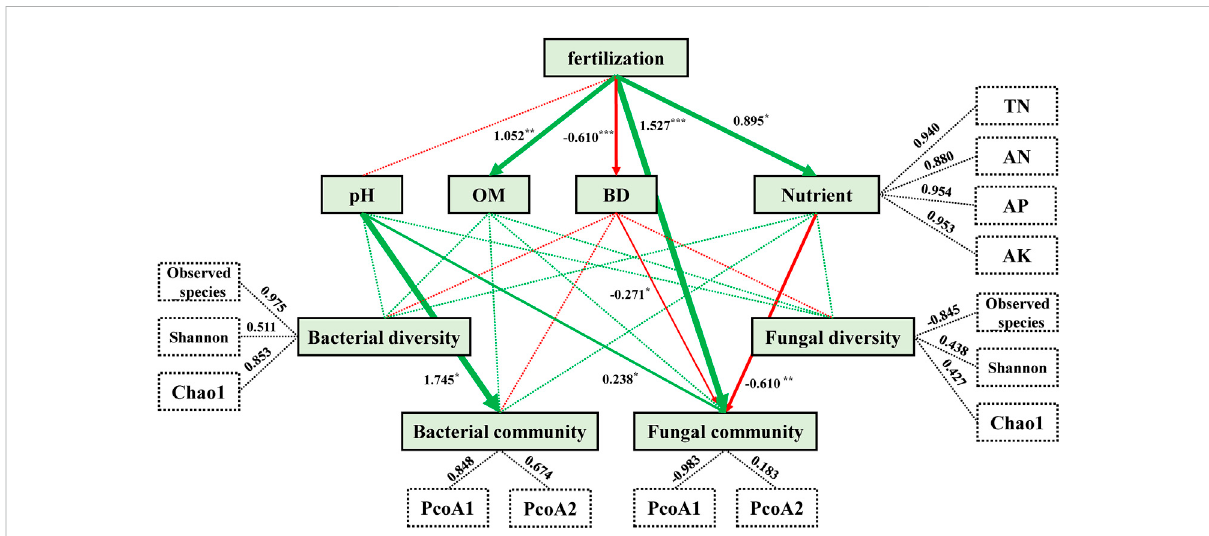
FIGURE 4 Directed graph demonstrating the partial least squares path model (PLS-PM) of the different treatments on soil microbial communities after 16years(2004 – 2019). Each boxrepresentsan observed (i.e.,measured)or latentvariable (i.e.,constructs).Dashedrectangles indicate nutrientloads andthreesoilmicrobial diversityindicesthatintroducepotentialvariability.Green arrowsindicate positiveeffects, whileredarrowsindicate negative effects, and arrow width is proportional to effect sizes. Dashed lines indicate the lack of signi fi cant effects ( p > 0.05). Path coef fi cients were calculatedafter1,000bootstrapsandarere fl ectedinarrowwidths.Asterisksindicatethedegreeofin fl uence:* p < 0.05,** p < 0.01,*** p < 0.001.The model was assessed using the Goodness of Fit (GoF) statistic, with a corresponding GoF value of